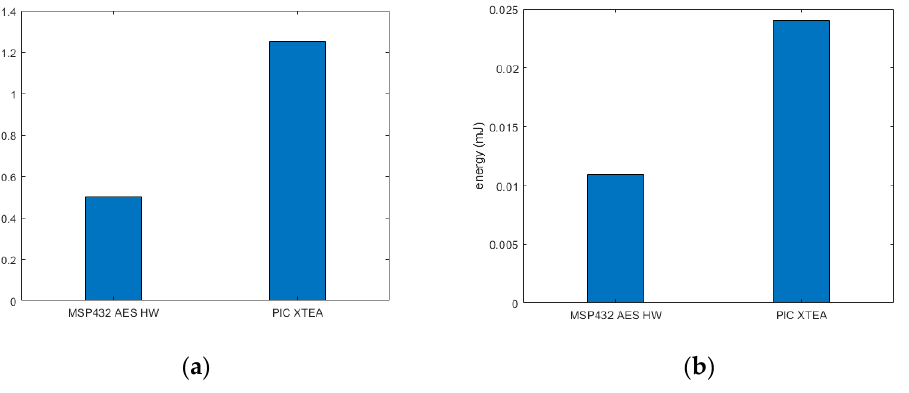
Figure 13. Comparative metrics for different encryption algorithms: ( a ) Execution time; ( b ) Energy consumption.